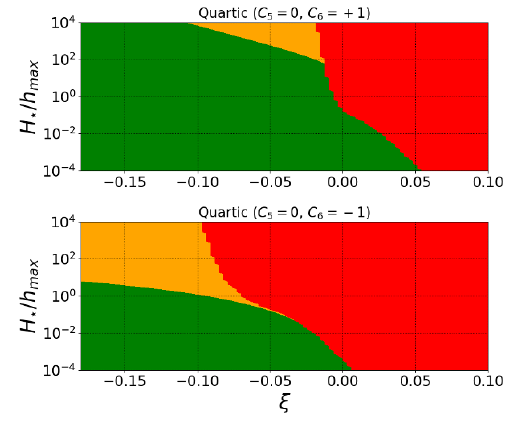
(a) Fate of the Higgs without derivative opera- (b) Impact of the dimension-six operator on the tors, for Starobinsky-like and quartic-like in(cid:13)a- fate of the Higgs for quartic in(cid:13)ation. tionary evolutions. Figure 5. Cosmological fate of the Higgs for di(cid:11)erent evolutions of the scale factor and parameters. The green region represent scenarios where there is not a single Hubble patch in our past light cone in which the Higgs has (cid:13)uctuated above the barrier. The orange region represents the potentially unsafe scenarios, in which there is no patch in AdS at the end of in(cid:13)ation, but there exist patches above the barrier that can potentially become AdS regions depending on the post-in(cid:13)ationary dynamics. In red: the region in which there exists at least one Hubble patch in AdS at the end of in(cid:13)ation, and the corresponding model cannot describe our observable universe. The red dashed curved on the left plots highlights the would-be boundary of the red region if the (cid:12)nite time to fall into AdS was not taken into account. All plots are obtained considering the noise in the stochastic process given by the function f in eq. (2.23). The dashed black lines on the top left plot mark o(cid:11) the boundaries between the three regions for the benchmark analysis assuming H constant and f